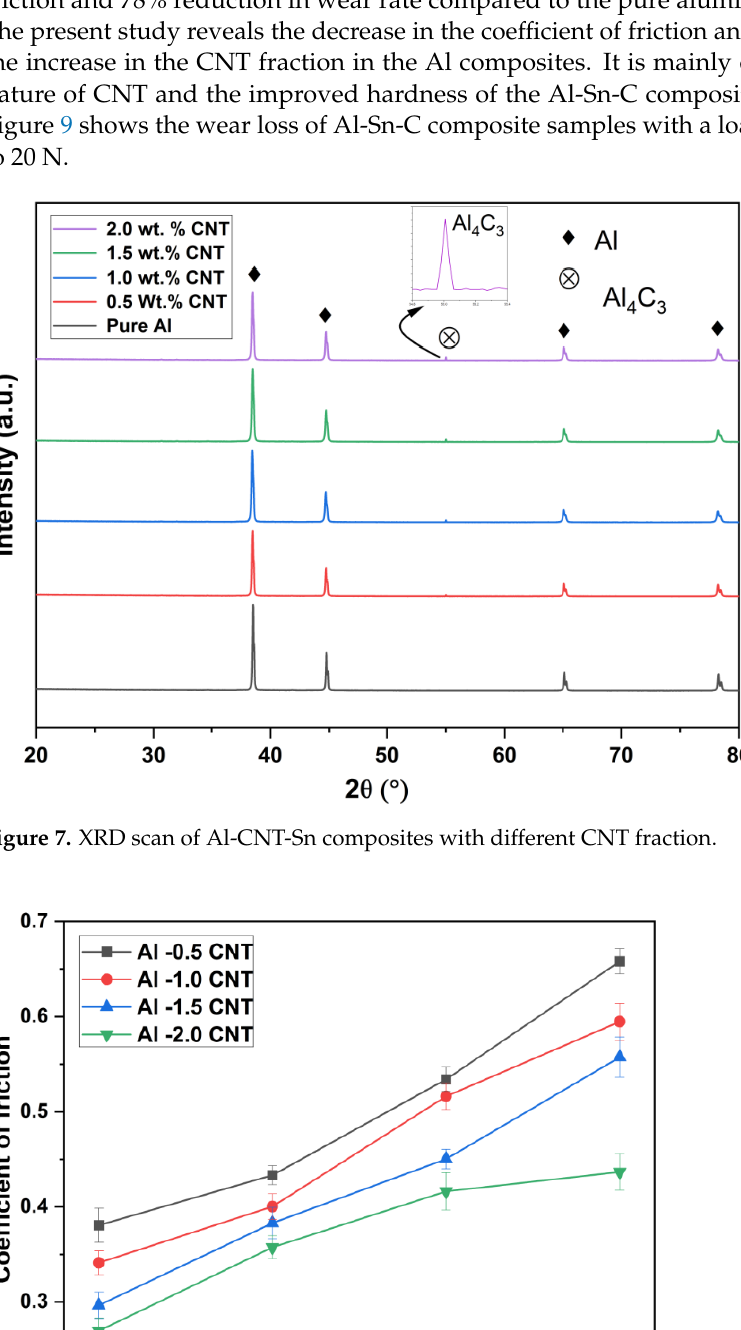
Figure 9. Effect of applied load on wear loss for composite samples prepared with different CNT content in dry sliding condition. Figure 10 depicts how the coefficient of friction increases with an increase in the op- erating temperature of the sample. We studied Al-CNT-Sn samples with 1.0 wt. % CNT under a range of load conditions and operating temperatures. Theoretically, the coeffi- cient of friction should decrease with an increase in operating temperature as the material softens at a higher temperature. In this case, the increment in friction coefficient might be due to the hardening effect of the specimen caused by the surge in temperature. An equal increment in coefficient of friction is noticed with an increase in test temperature by Jag- annathan et al. and Kumar et al. [32,33]. Figure 11 displays the increase in wear loss with the increase in operating temperature and the applied load.